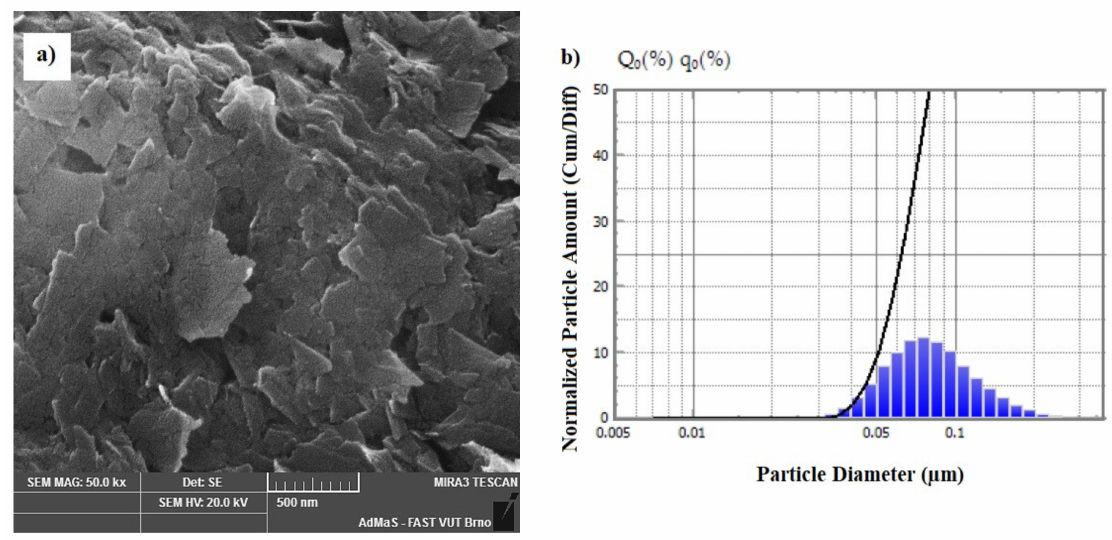
Figure 2. Dispersed concentrate of carbon black in an aqueous surfactant solution: ( a ) the microstructure of carbon black particles in an SEM image ( × 50,000); ( b ) particle size